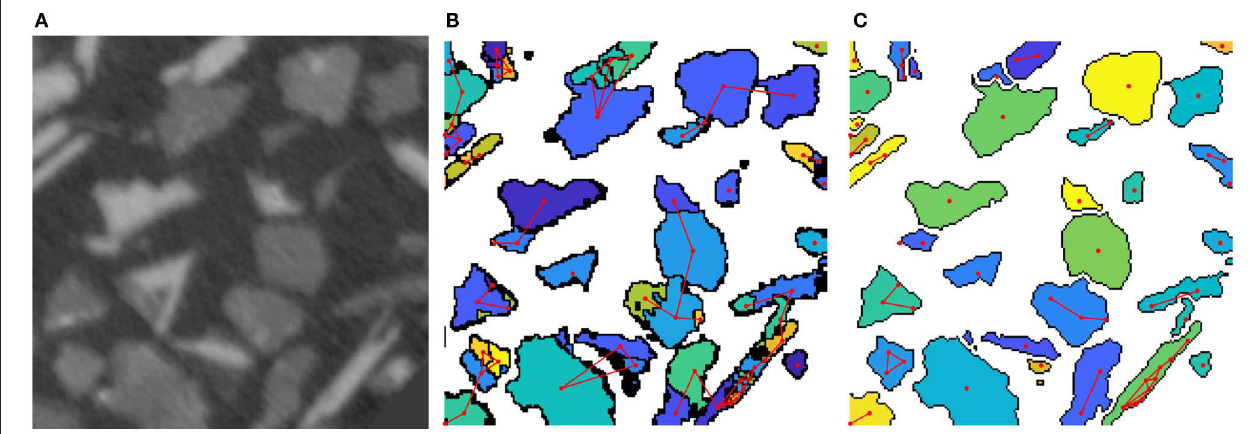
FIGURE 2 | (A) 2D cut-out of tomographic image data of ore particles. (B) Oversegmented image obtained by the watershed transformation. Red lines are set between adjacent regions. Note that some regions are adjacent in 3D but not in the visualized planar section. (C) Segmentation after a postprocessing step using a neural network.